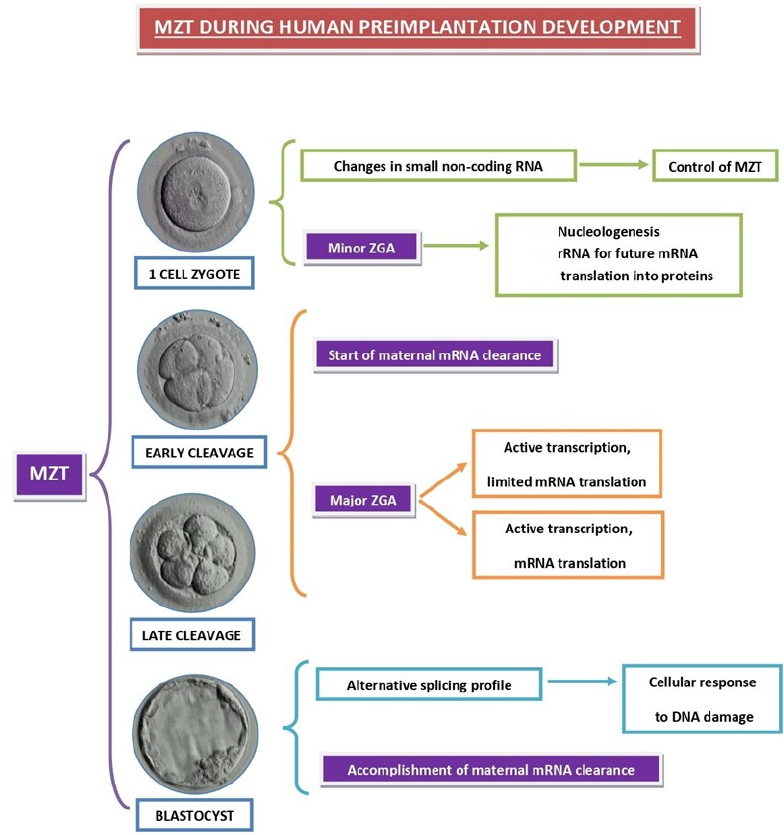
Figure 3. The main events that occur during MZT in human preimplantation